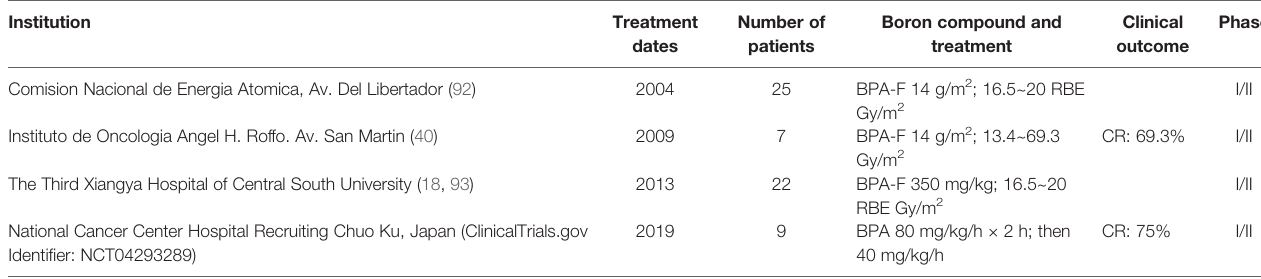
TABLE 4 | Clinical studies of BNCT application in